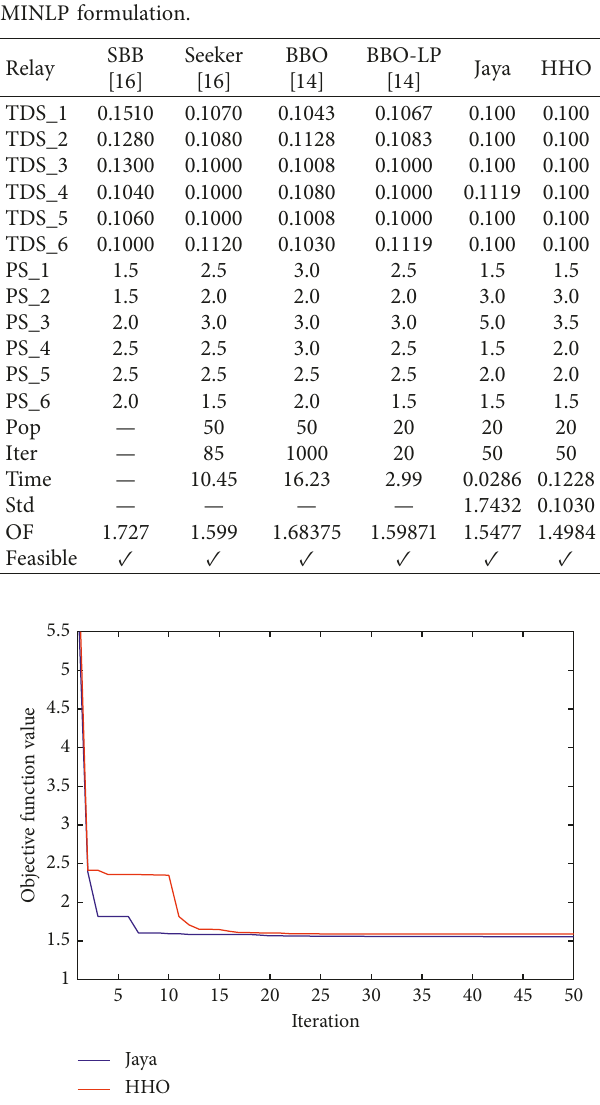
Figure 6: Convergence characteristics for the 3-bus system by MINLP